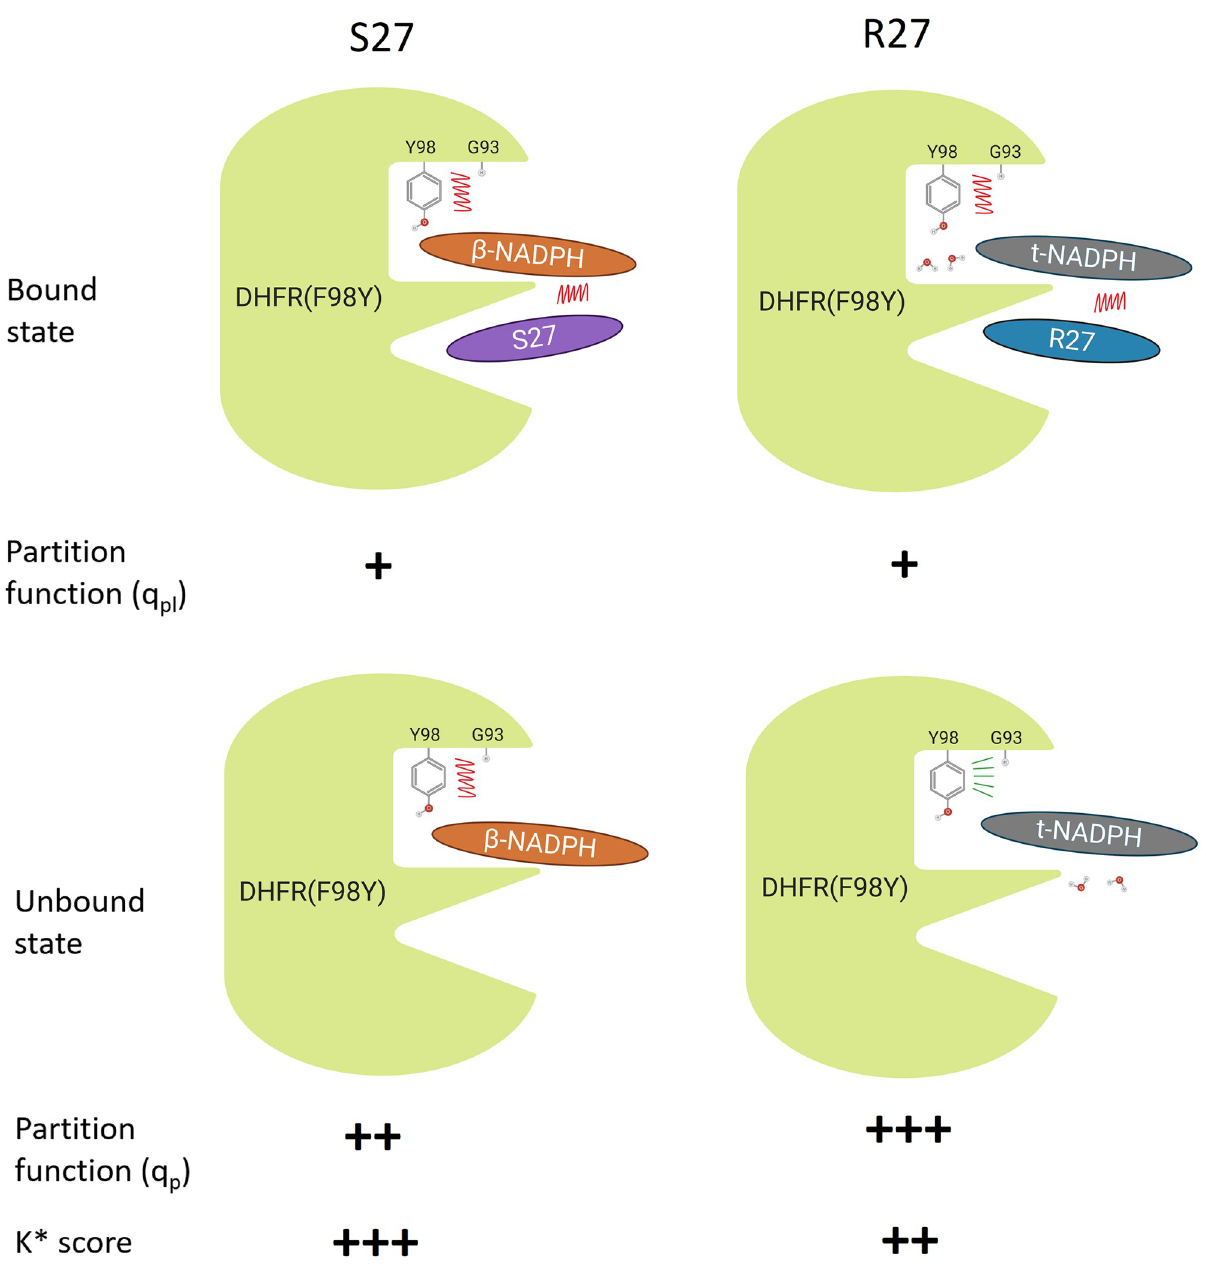
Fig 8. Proposed mechanism for chiral evasion of SaDHFR and resistance resilience by PLAs. R-27 and S-27 have almost equal potency when bound to WT DHFR. However, S-27 binds significantly more tightly to F98Y DHFR than R-27 does. The different configuration of NADPH cofactor played an important role, which we term chiral evasion, according to our data. F98Y mutation introduces steric clashes (red jagged lines), and thus makes the whole complex energetically less favorable. By exploiting chiral inhibitor design, an inhibitor (S-27) from a PLA enantiomer pair was obtained that is resilient to chiral evasion. The opposite anomer R-27 is significantly less resilient. When R-27 binds to F98Y DHFR, it binds together with t-NADPH and also two water molecules that bridge the interaction. According to the OSPREY predictions, in the unbound state, the two water molecules move away from the binding pocket and move towards the space left by the absence of the inhibitor. Consequently, the crowding in the binding pocket is alleviated and the clashes can be relieved (green radial lines) in the unbound state. In contrast, when S-27 binds to F98Y DHFR, it only binds together with β - NADPH (without any water molecules) and the clashes cannot be relieved in the unbound state. Therefore, as a quotient of bound and unbound state partition function, the K � score (which approximates K ) of S-27 is higher than that of R-27. This suggests S-27 should bind tighter to F98Y DHFR than a R-27 does; furthermore this prediction agrees with IC 50 data. Design for resilience to chiral evasion can therefore overcome drug resistance in a protein target.